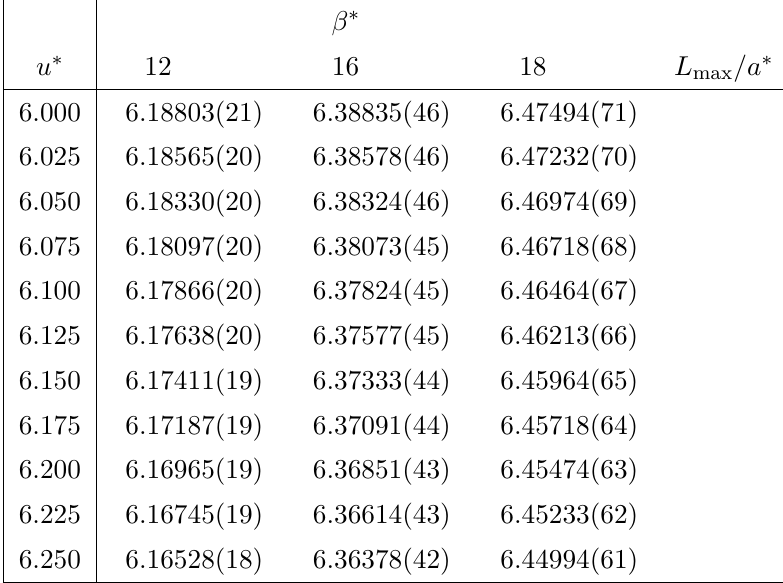
Table 11 . The bare coupling (cid:12) (cid:3) at the renormalization condition u (cid:3) .